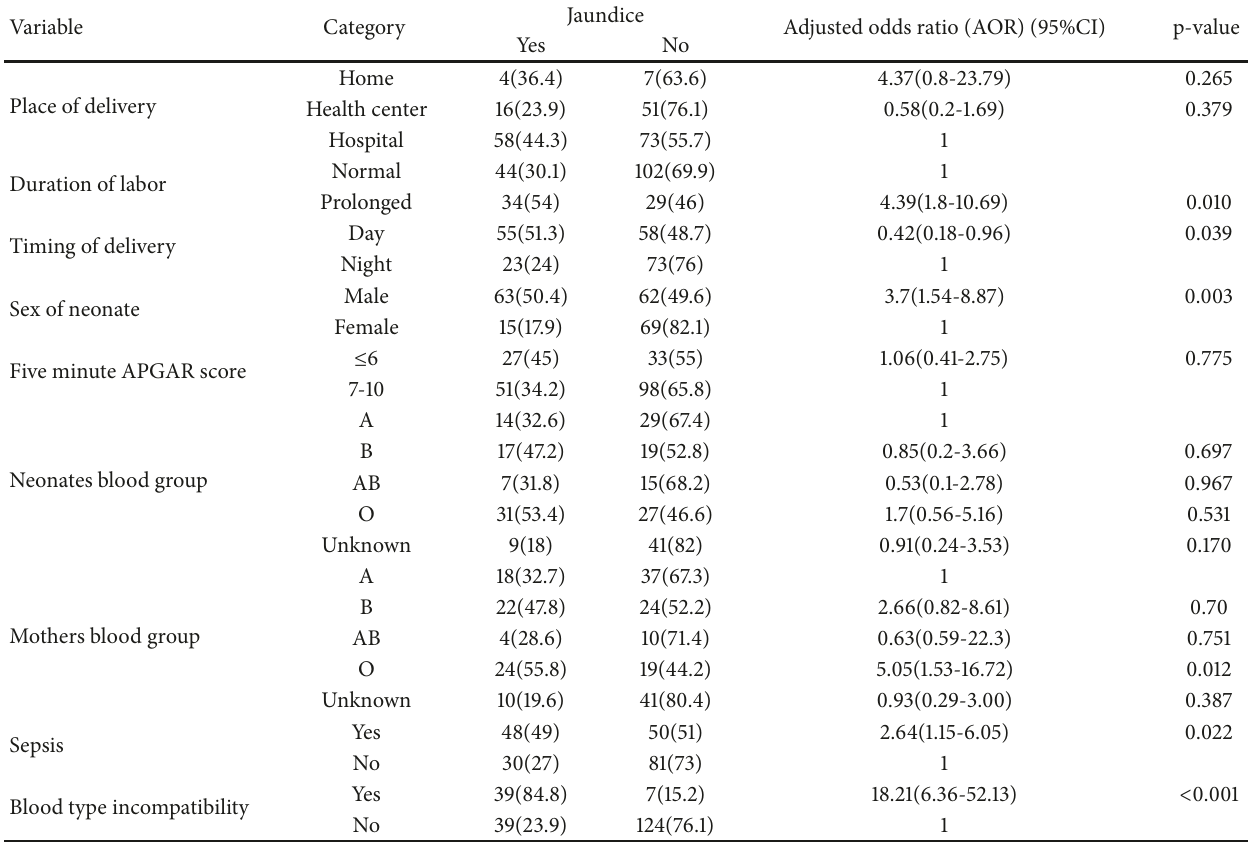
Table 4: Multivariate regression analysis of different variables with neonatal jaundice among neonates admitted to neonatal intensive care unit of Mekelle city public hospitals, Northern Ethiopia,